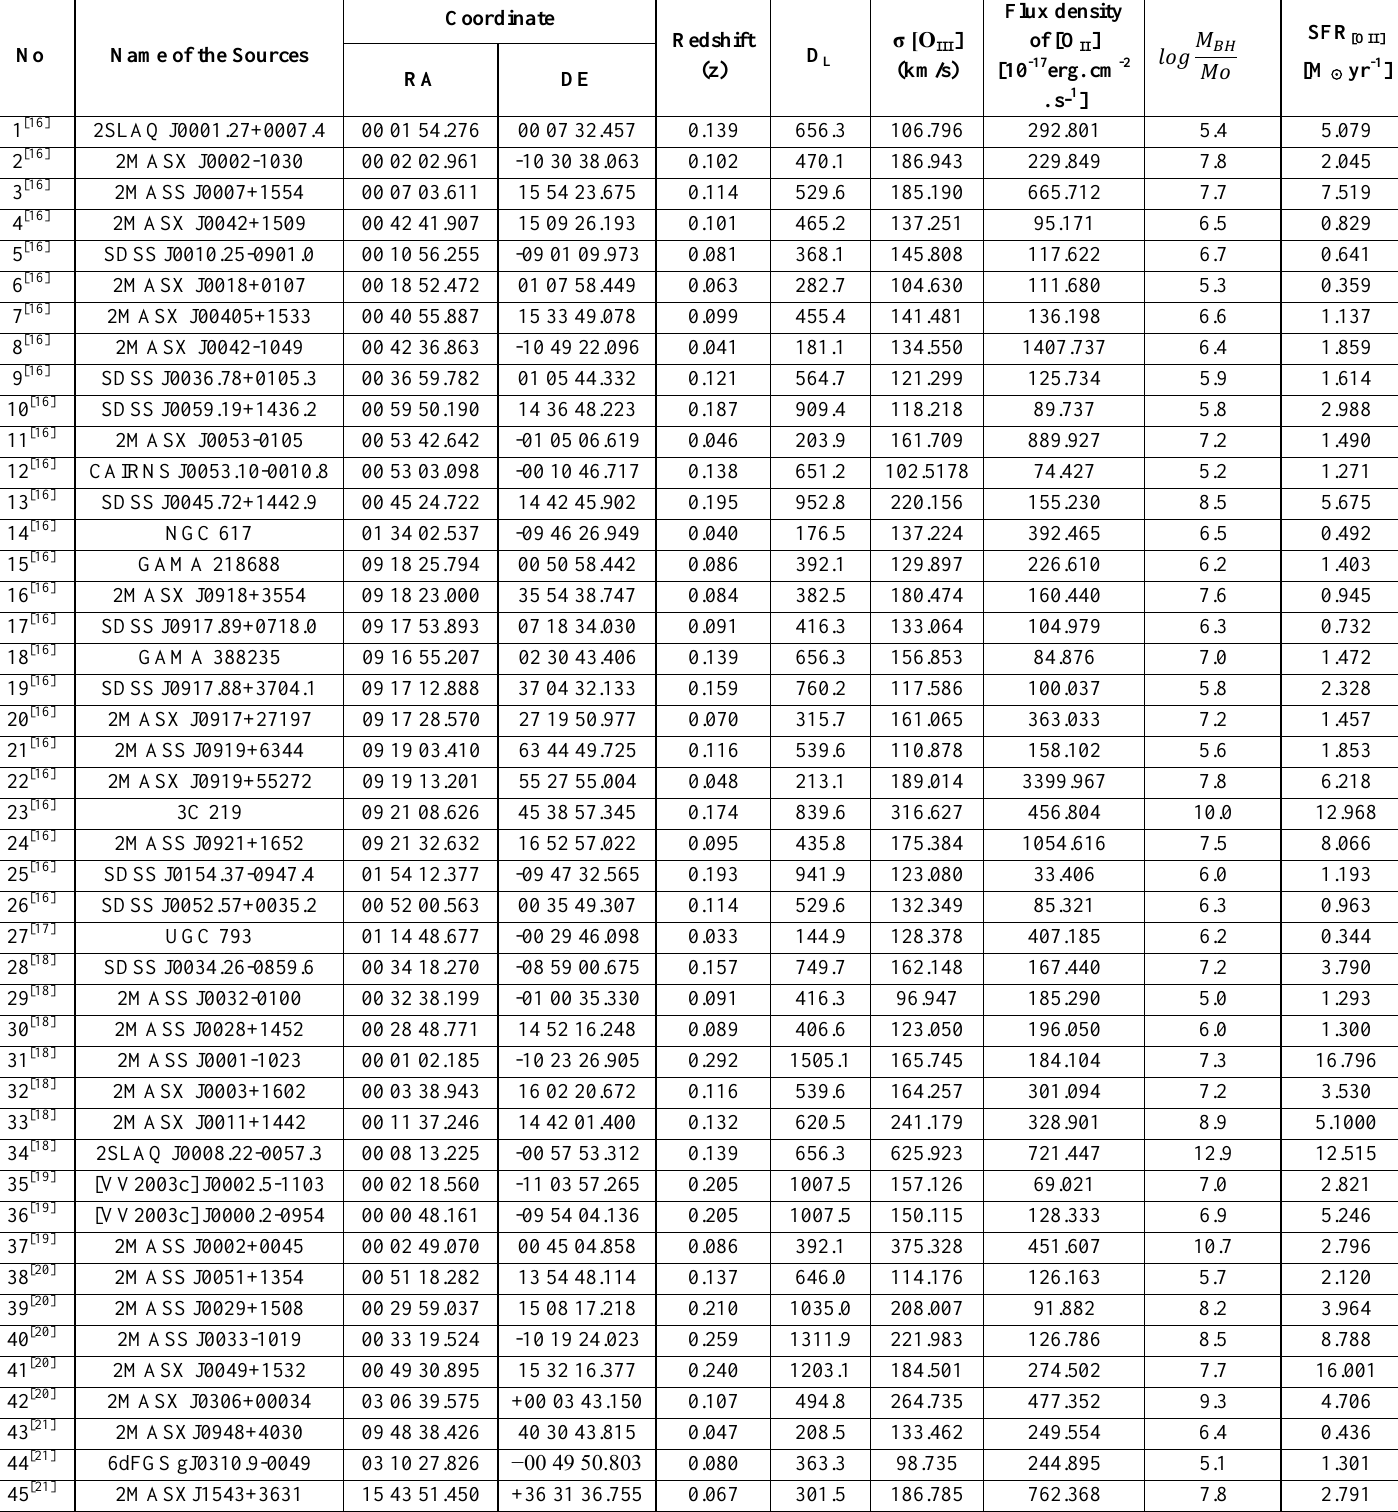
Table 1: The data for Sy1